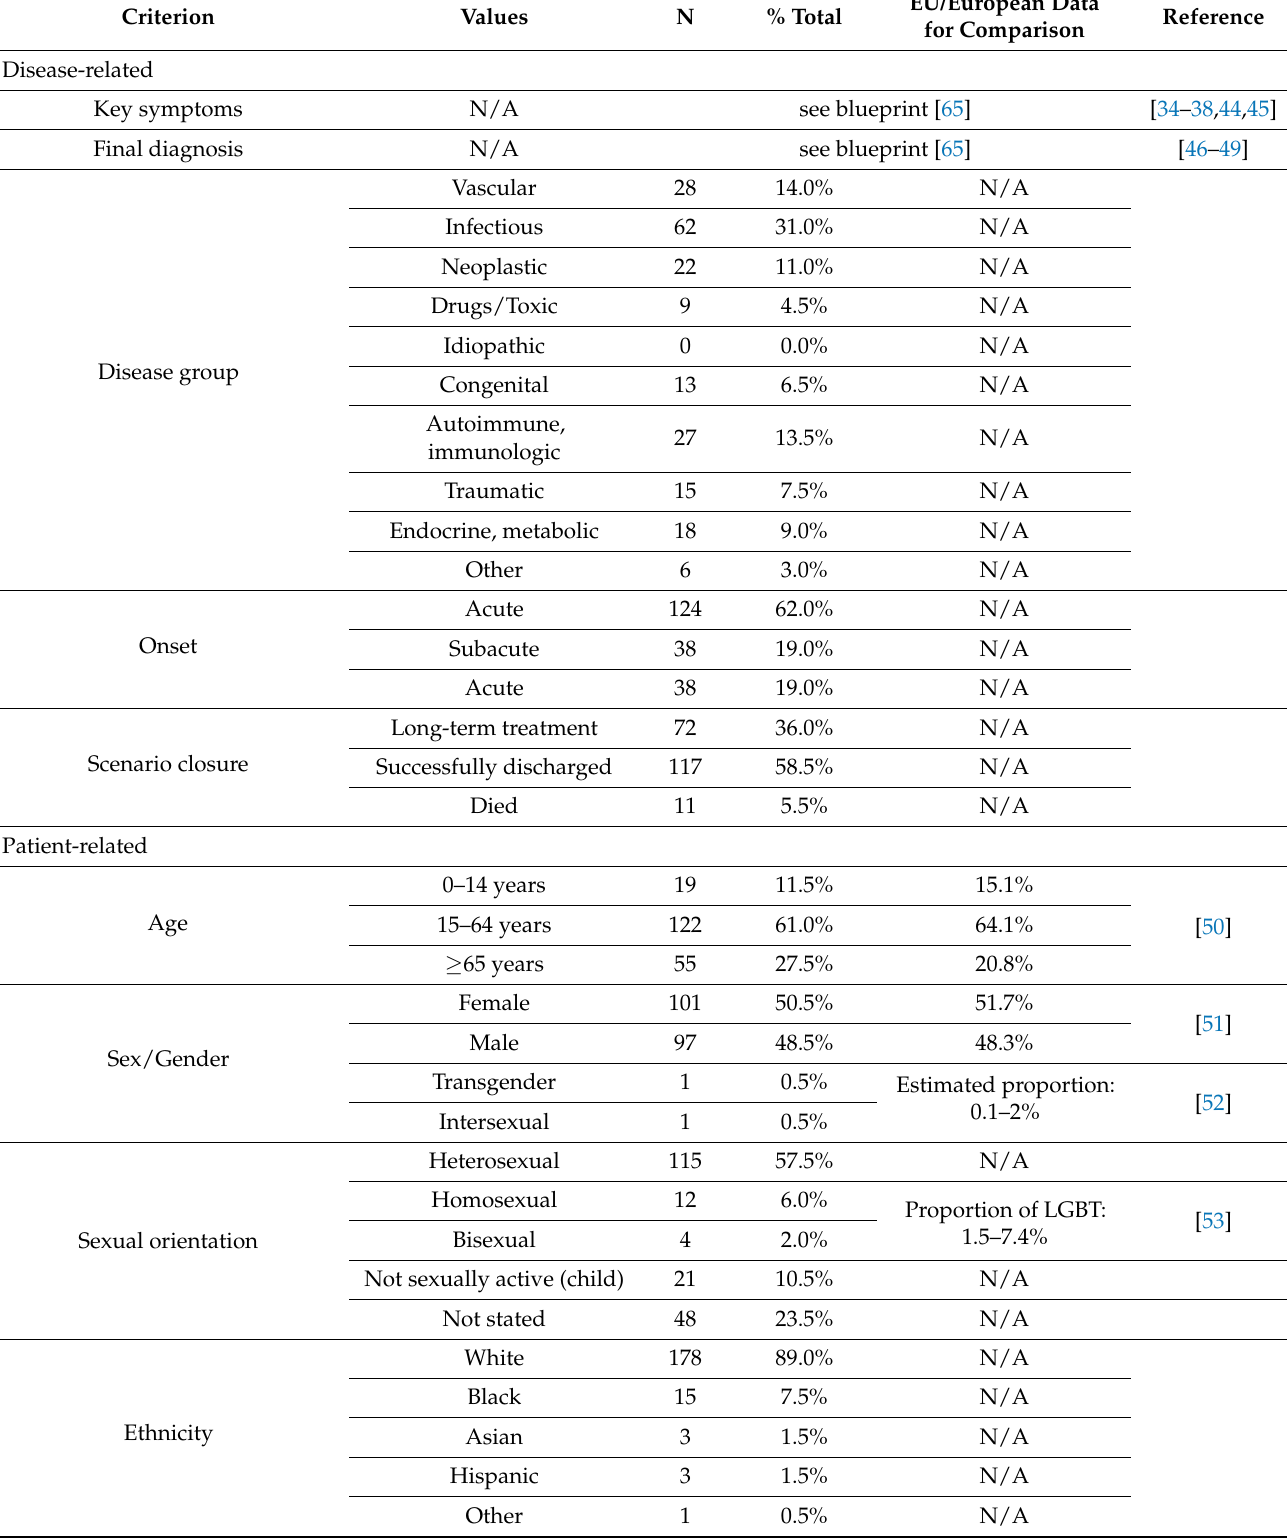
Table A1. Analysis results of all disease-, patient-, learner- and encounter-related